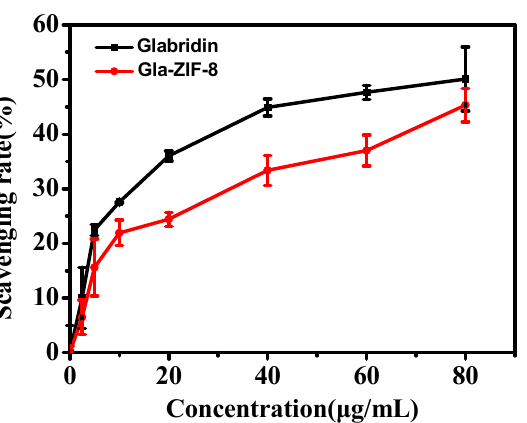
Figure 5. DPPH radical-scavenging capacities of free glabridin and Gla-ZIF-8.